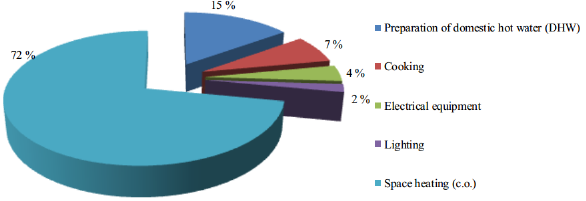
Figure 1: Structure of energy consumption in residential buildings in Poland. Source: Own study based on